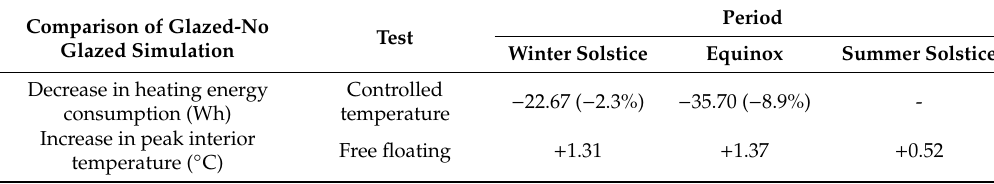
Table 6. Average reduction of heating energy consumption (Wh) and average increase of the interior air temperature ( ◦ C) when it is used the passive strategy of direct solar gains through the glazed